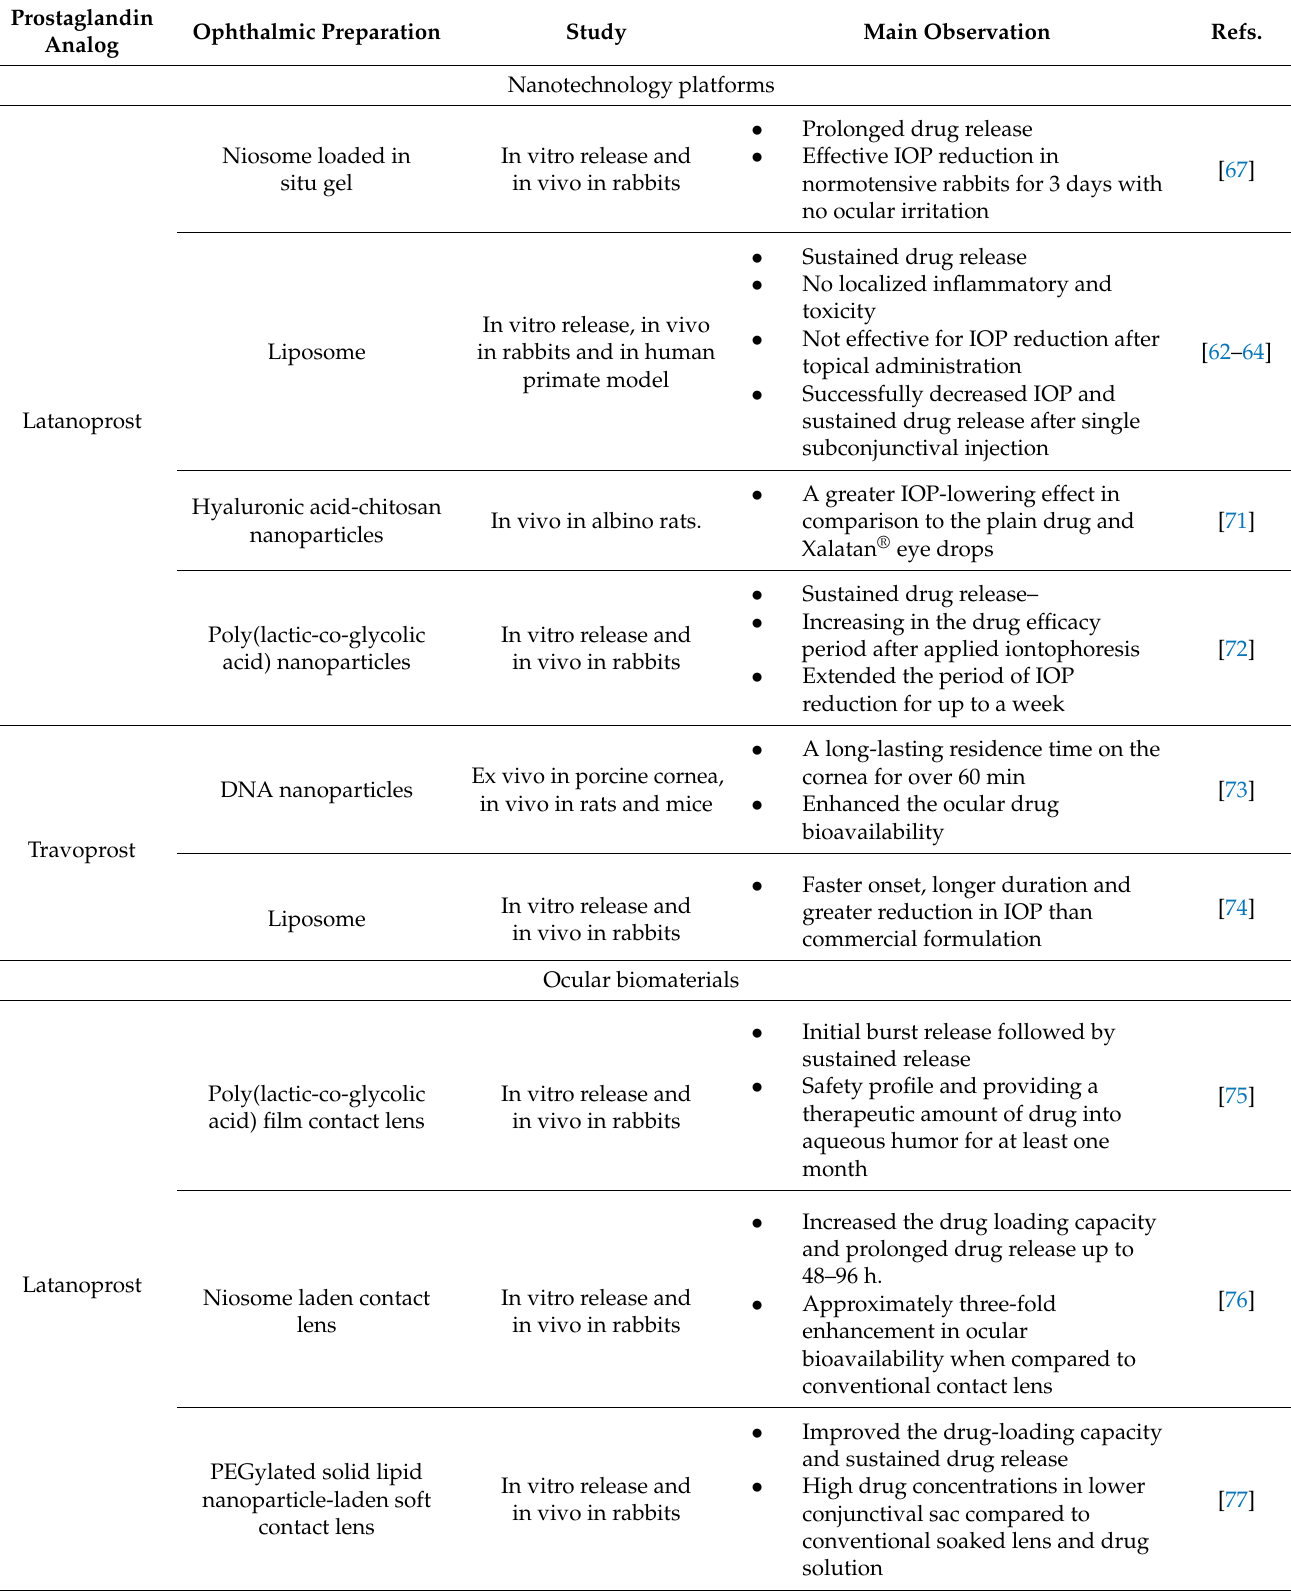
Table 2. Case examples of PGA-loaded nanotechnology-based formulations and ocular biomaterial containing PGA for treatment of glaucoma.